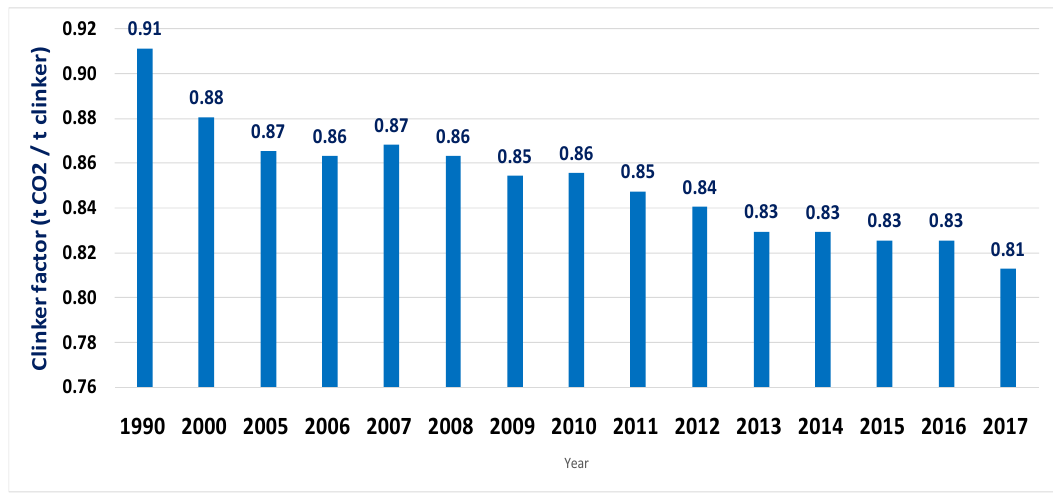
Figure 3. Clinker factor in the group of 28 countries of the European Union (EU) known as EU28 cement industry from 2005 to 2017 plus 1990 and 2000 [29].